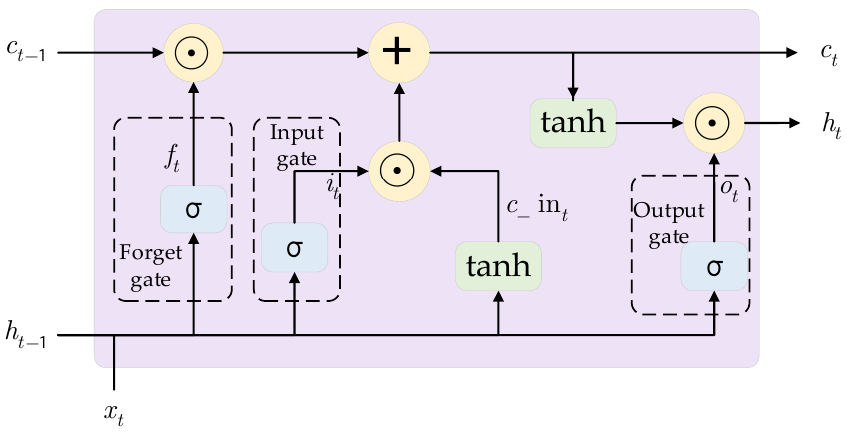
Figure 7. Architecture of the LSTM block.